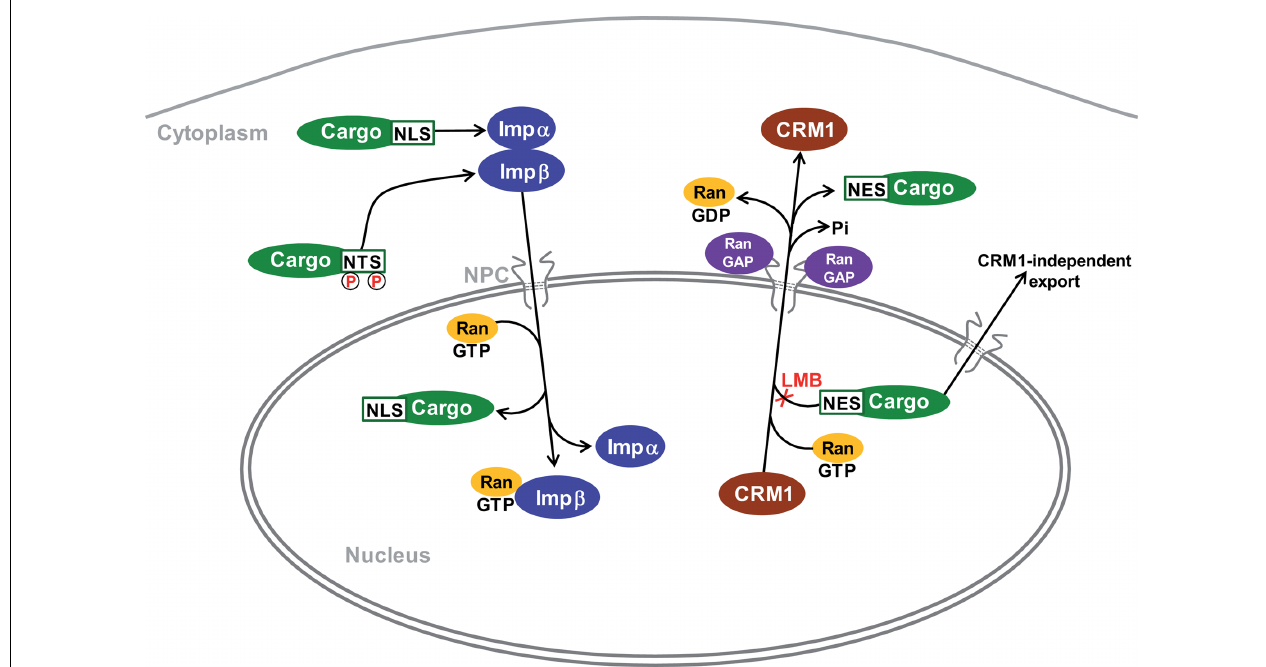
hydrophobic nuclear export sequence (NES) bind to CRM1 in the presence of RanGTP. Following translocation the complex is dissociated through hydrolysis of GTP by Ran GTPase-activating proteins (Ran GAPs) enriched on the cytoplasmic side of the NPC. Leptomycin B (LMB) prevents binding of NES to CRM1. CRM1-independent export pathways are poorly characterized. RanGDP is imported from the cytoplasm to the nucleus where GDP is replaced by GTP by specific guanine nucleotide exchange factors (GEFs, not shown). Following carrier-cargo dissociation, the empty importins or exportins return to their compartment of origin through specific pathways that are not indicated on the scheme. References can be found in the text and in (Pemberton and Paschal, 2005; Poon and Jans, 2005; Nardozzi et al.,